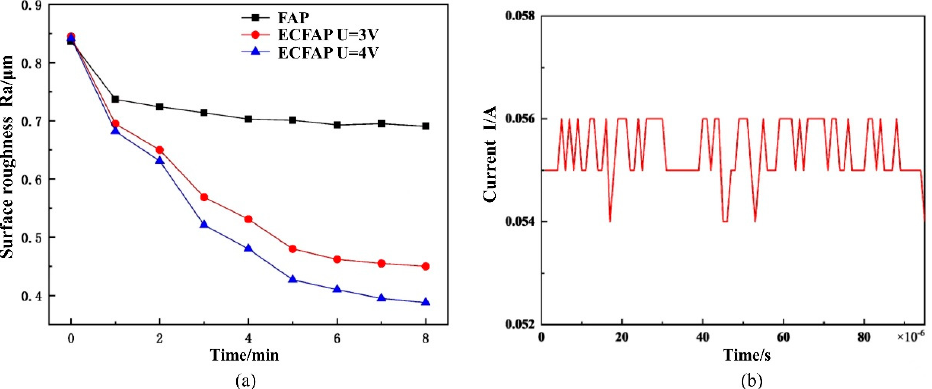
Figure 13. ( a ) Variation of surface roughness with time; ( b ) current vs. time curve during ECFAP (U = 3 V).